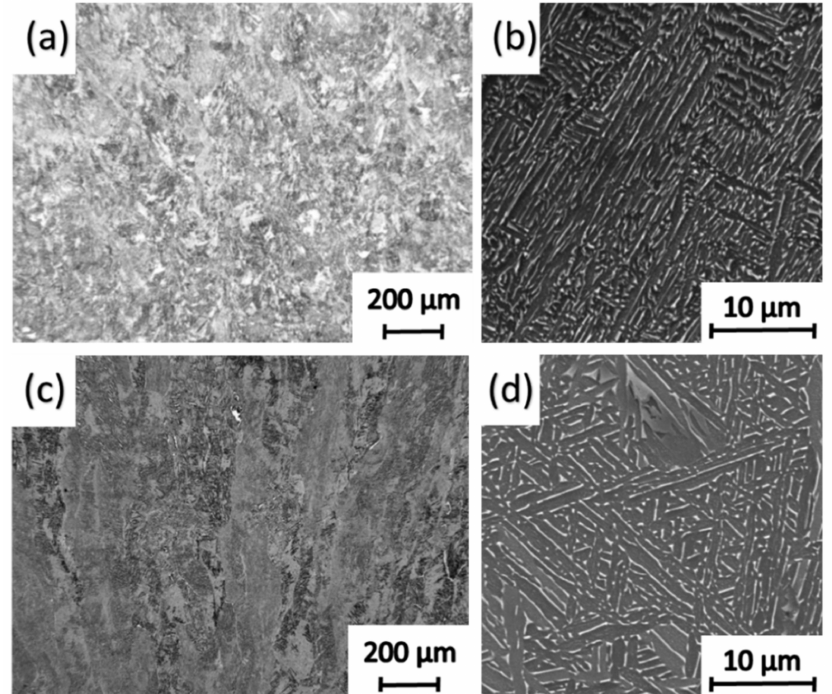
Figure 9. Microstructure of the flat EBM-processed specimens built in the ZXY orientation: ( a ) thickness of 1 mm, ( b ) detail of specimen with thickness 1 of mm, ( c ) thickness of 3 mm and ( d ) detail of specimen with thickness of 3